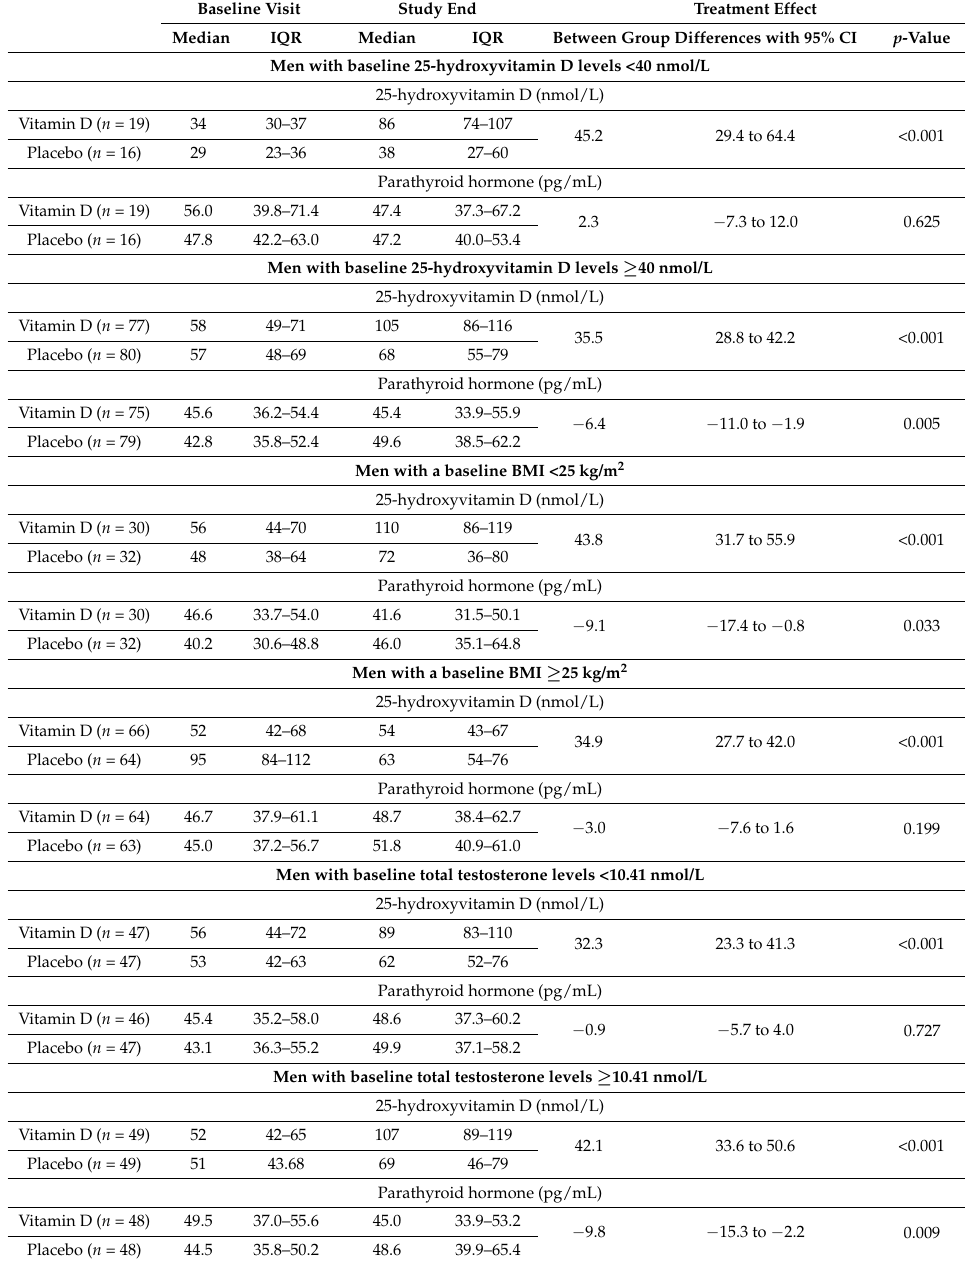
Table 3. Parameters of mineral metabolism at baseline and final follow-up at study end (12 weeks) in various subgroup analyses (study participants with baseline 25(OH)D levels <40 nmol/L and with baseline 25(OH)D levels ≥ 40 nmol/L; study participants with a baseline body mass index (BMI) <25 kg/m 2 and with a baseline BMI ≥ 25 kg/m 2 ; study participants with baseline total testosterone levels <10.41 nmol/L and with a baseline total testosterone levels ≥ 10.41 nmol/L) with available values at both study